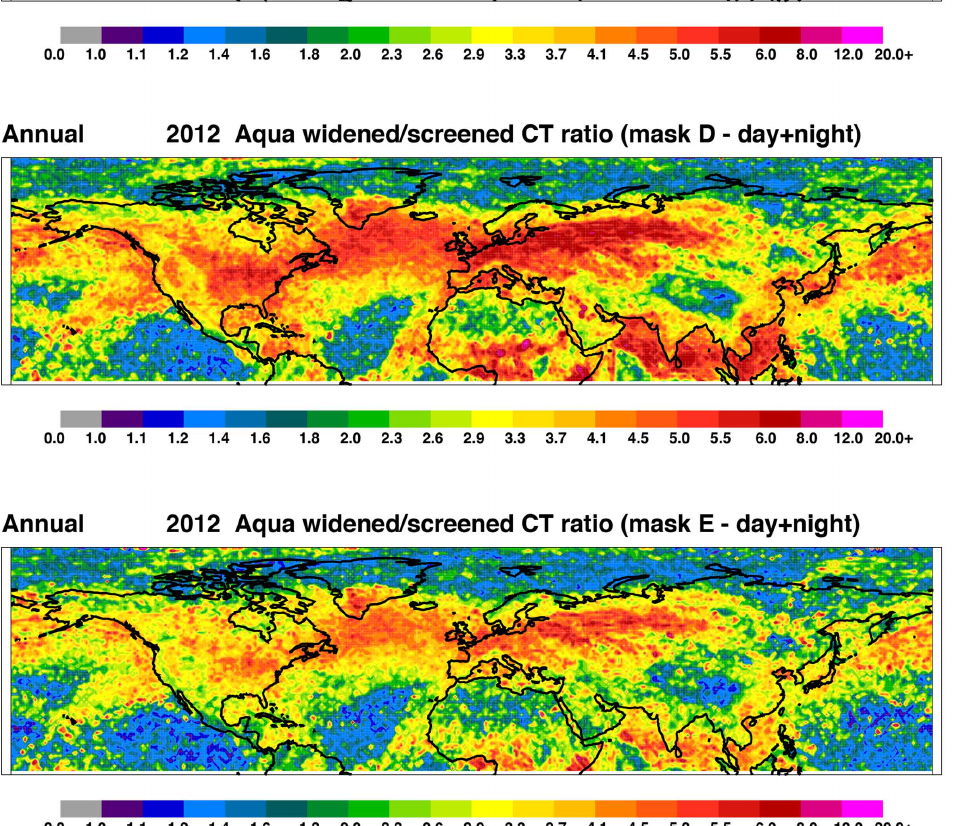
Figure 10. The 2012 annual-mean NH widened versus screened CC ratio from Terra and Aqua MODIS imagery (Mask D and